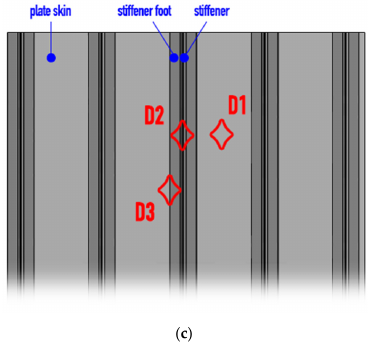
Figure 3. Composite flat-panel reinforced with T-stringers ( a ) front and ( b ) rear view of the panel and ( c ) schematic index of locations of barely visible impact damages.